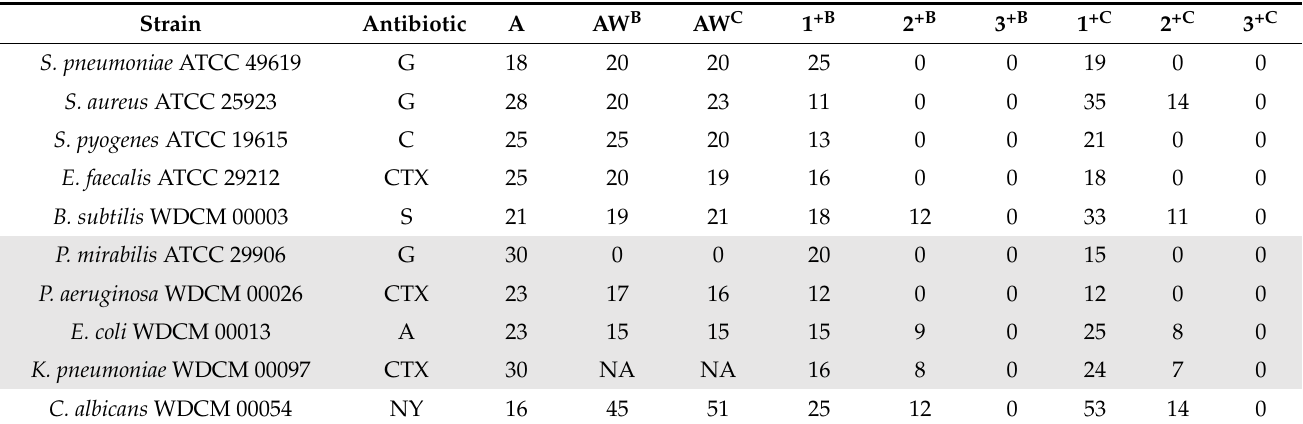
Figure 10. The Agar Well (AW) analysis of the title compound (with concentrations of 11, 5.5, and 2.75 μ g/mL). From left to right: ( a ) C. albicans WDCM 00054; ( b ) S. aureus ATCC 25932 ; and ( c ) S. bacteria. 0 = Resistant. No statistically significant differences ( p > 0.05) between row-based values through pneumoniae ATCC 49619. Pearson correlation. The results are similar to the antimicrobial action of [Cu(12-crown-4) 5 (H 2 O) 6 ]I 6 x 2I 2